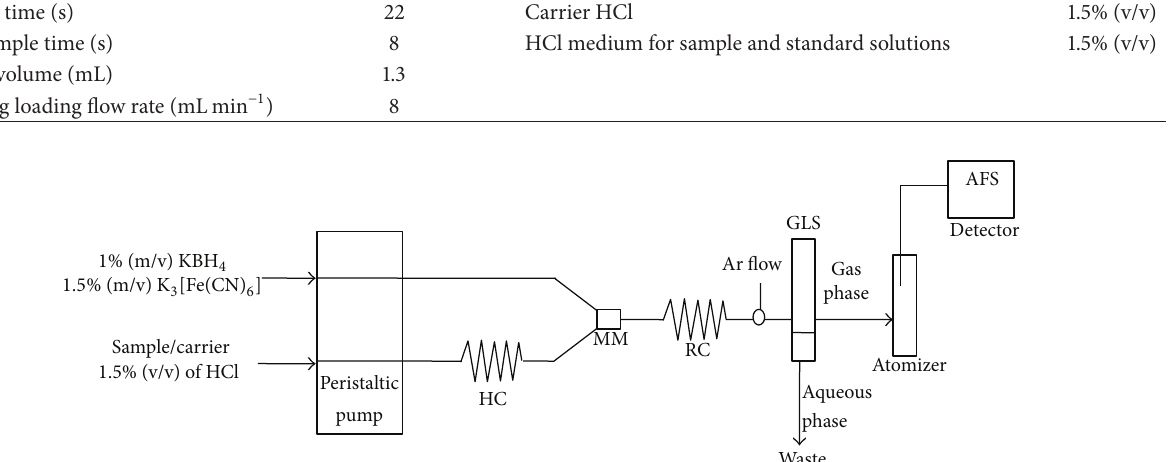
Figure 1: Schematic representation of flow-based hydride generation-atomic fluorescence spectrometry system, FIA-HG-AFS. HC: holding coil; MM: mixed module; RC: reaction coil; GLS: gas-liquid